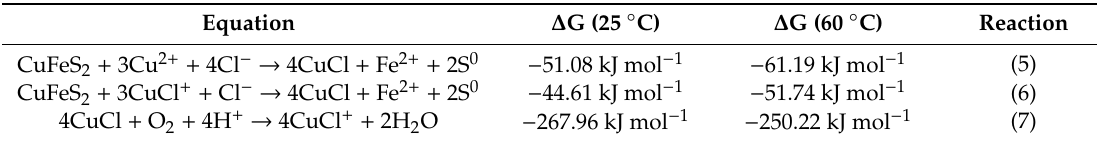
Table 4. Calculated Gibbs free energies for the proposed oxidation